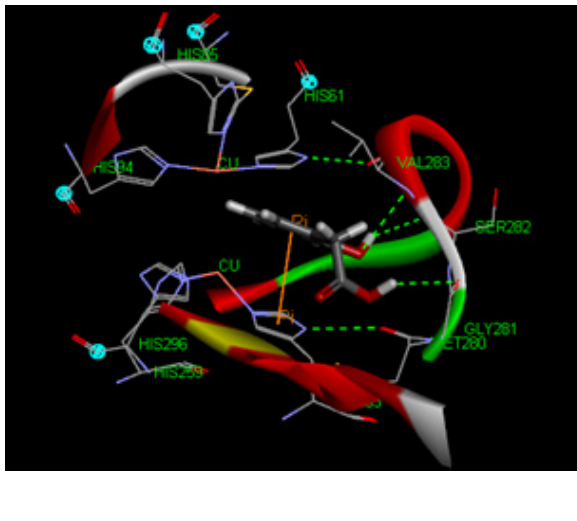
Figure 12. The docking of 2-hydroxyphenylacetic acid ( 7 ) into the active site of mushroom tyrosinase. The acetic acid moiety of 2-hydroxyphenylacetic acid ( 7 ) introduced one hydrogen bond with GLY281 and its OH group built two hydrogen-bonds with VAL283 and SER282. The aromatic ring of 2-hydroxyphenylacetic acid ( 7 ) interacted with HIS263 through π – π